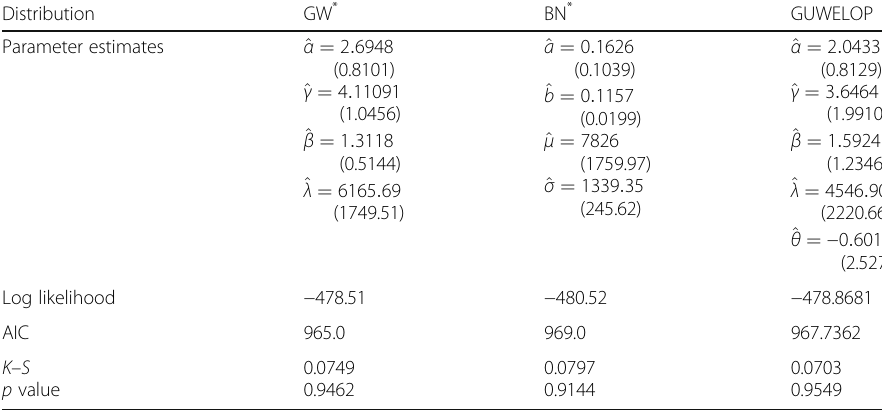
Table 9 Maximum likelihood estimates for Kevlar 49/epoxy strands failure times data (pressure at